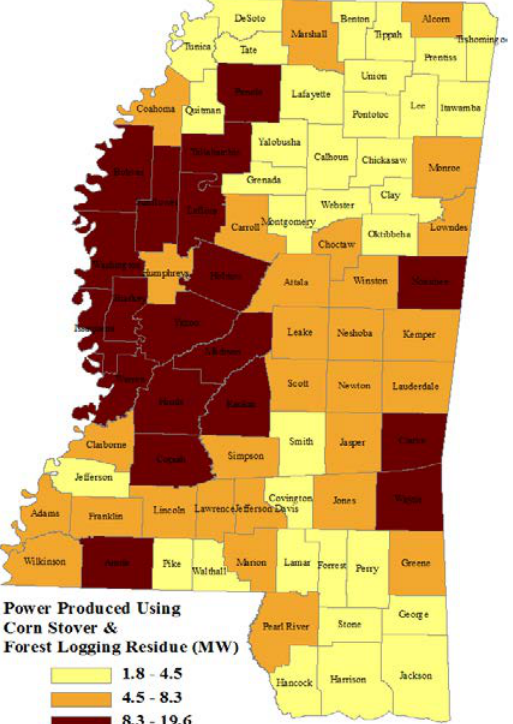
Figure 6. County-level potential CHP capacities (MW) for Mississippi based on combined use of corn stover (33%) and forest logging residue